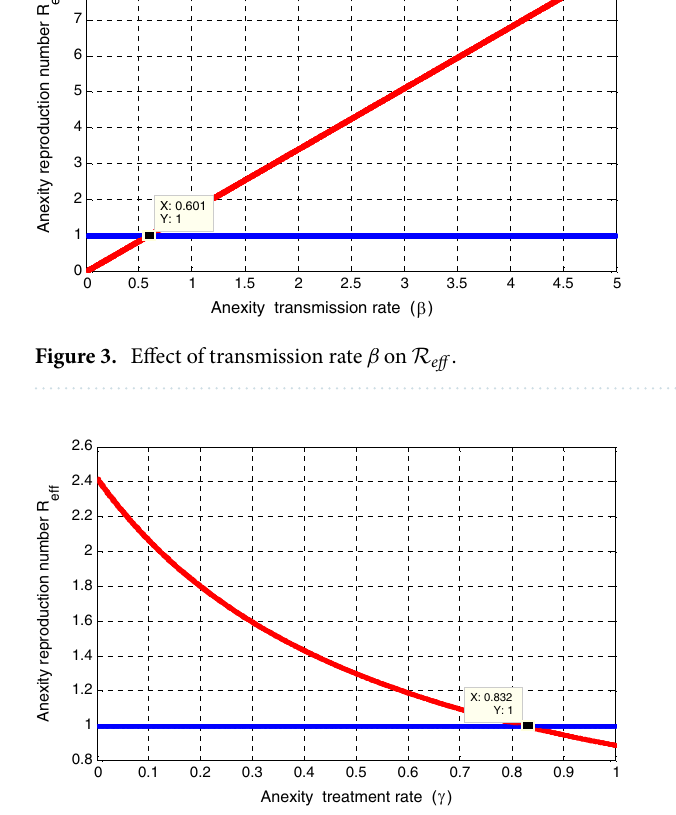
Figure 4. Effect of treatment rate γ on R eff .